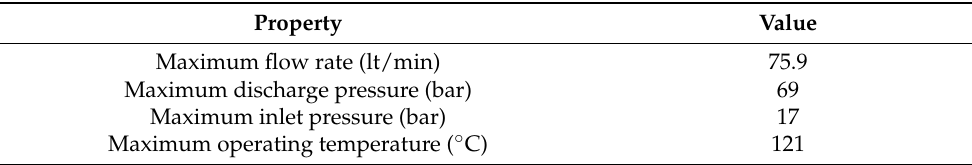
Table 3. Design specifications of Hydra Cell G25-E pump